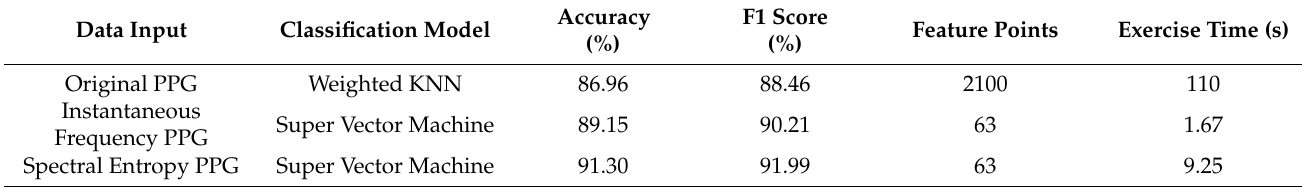
Table 8. Signal input comparison.